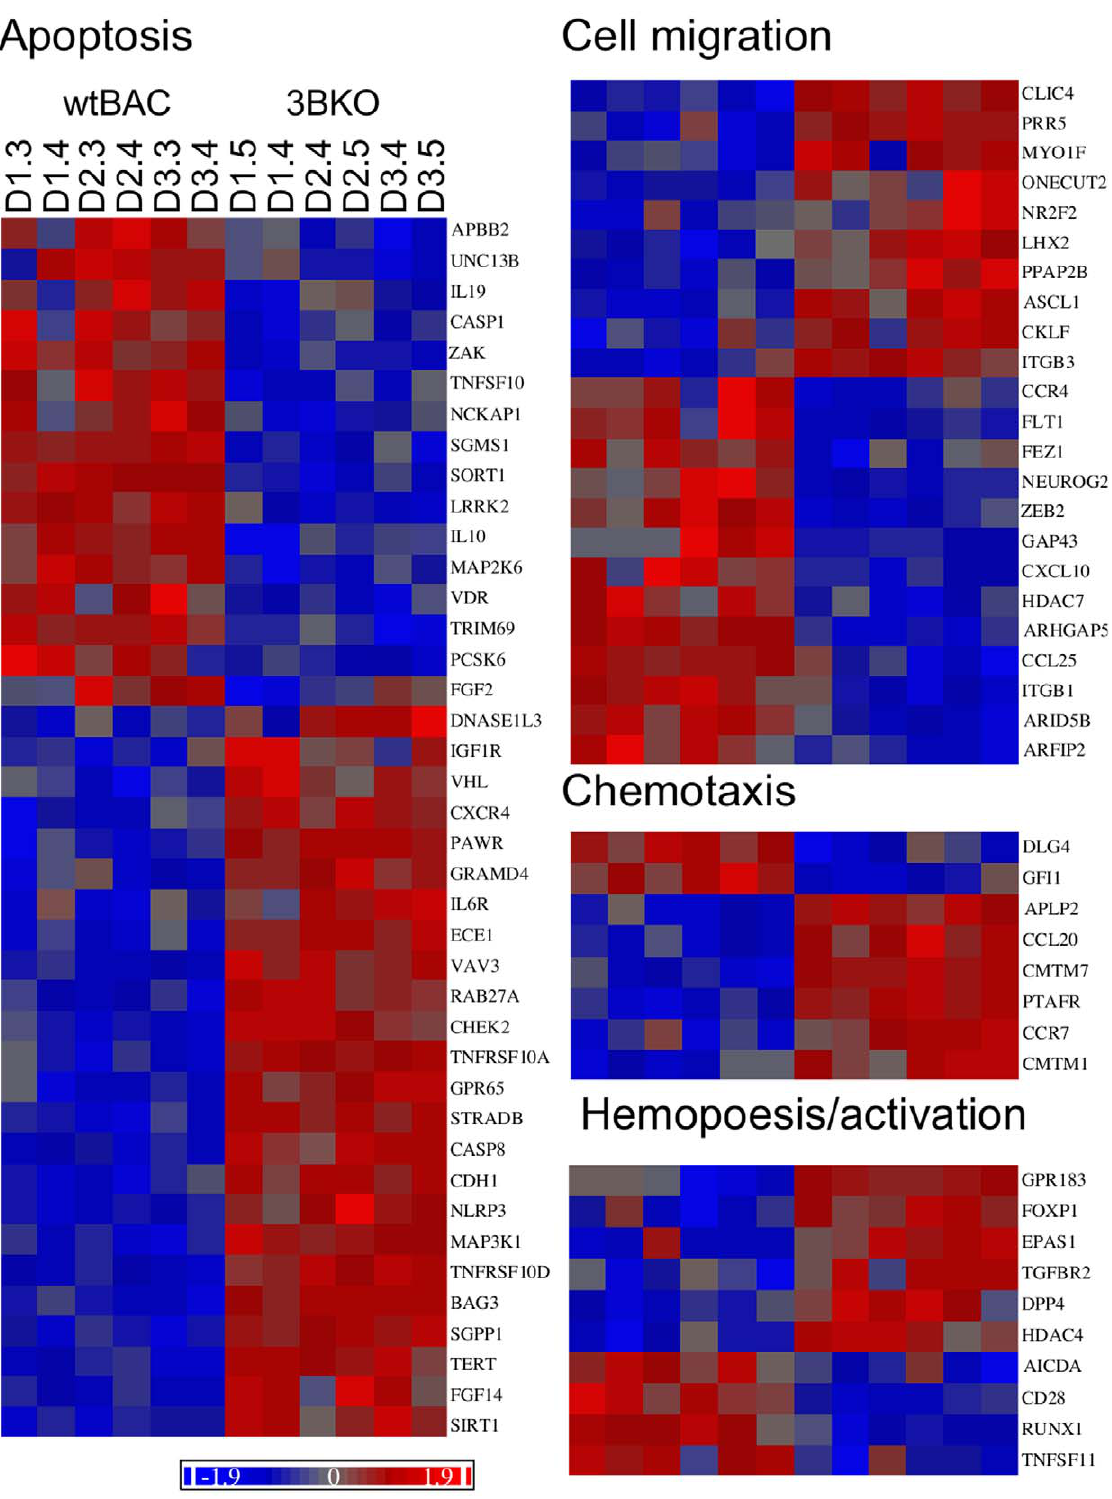
Figure 9. Ontological groupings of EBNA3B-regulated genes in LCLs. MMBGX-extracted gene expression levels were normalised to the mean and scaled by the standard deviation of gene expression levels in LCLs for each gene, and coloured by relative expression (see scale). These were grouped by ontological term, and where genes fell into multiple groups, they were placed in the group in the following order - apoptosis, cell migration, chemotaxis and then hemopoesis/activation. Genes within each group were ordered by unsupervised clustering. Cell clone IDs are indicated at the top of the apoptosis heatmap and are in the same sequence for other categories.